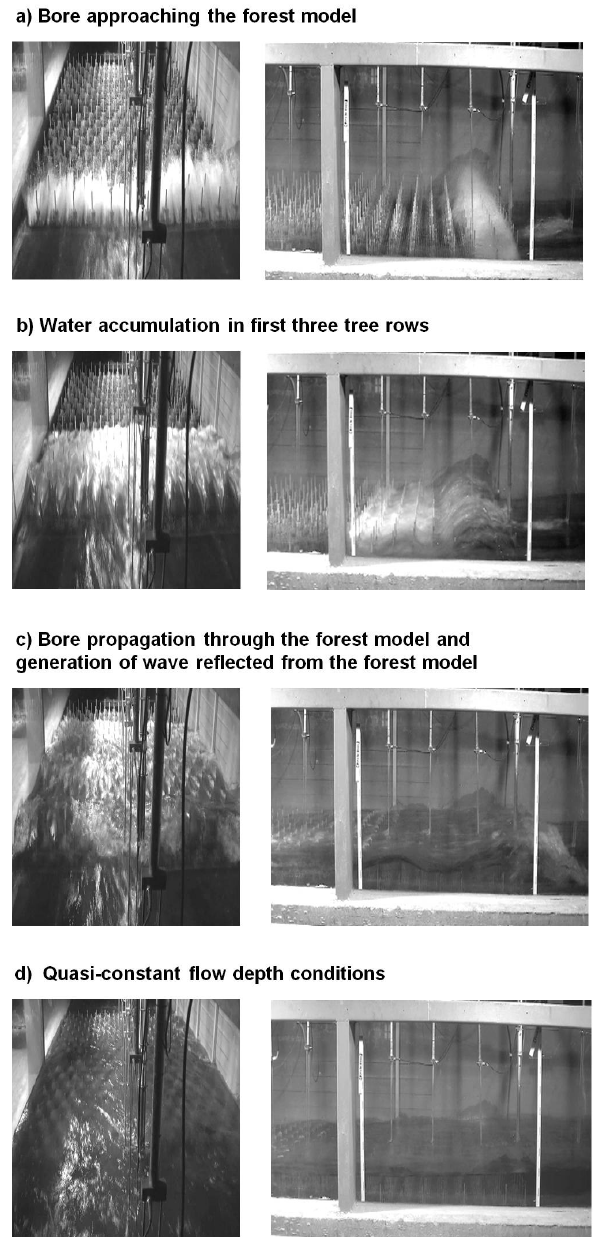
Fig. 8. Selected snapshots of tsunami bore propagation through forest model of width B = 3.0m (water depth behind bore gate h o = 0.8m, water depth in front of bore gate h 1 = 0.3m).